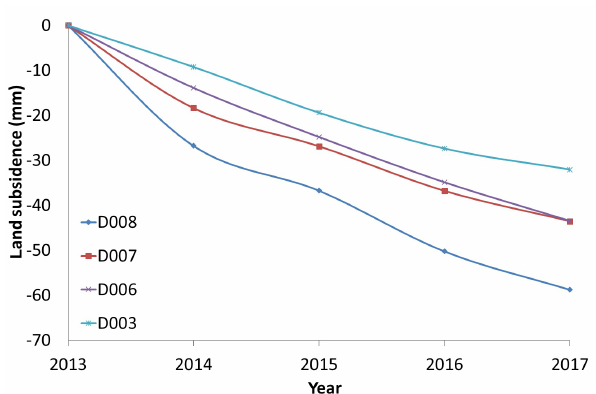
Figure 3. Land subsidence curves (silty dredger at D001 and clay dredger at D002).